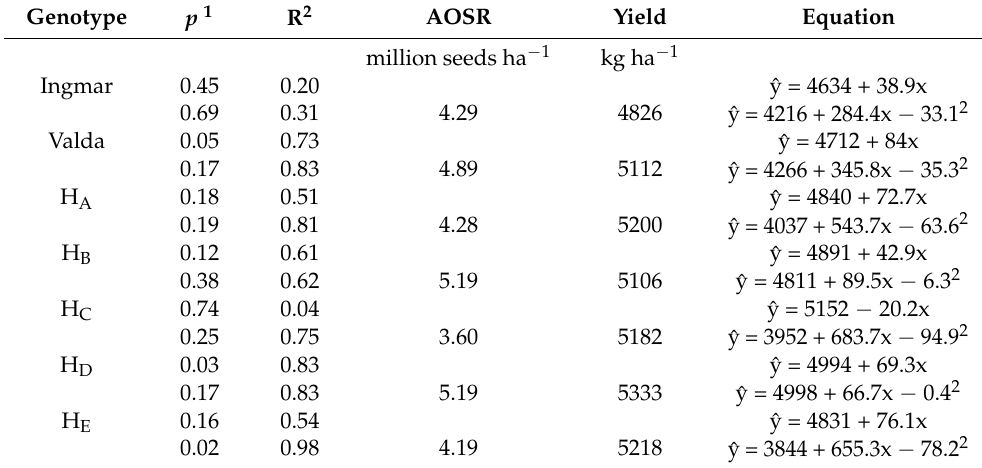
Table 7. Linear and quadratic regression analysis for seeding rate (x) and yield (ˆy) by genotype averaged across seven environments in North Dakota,